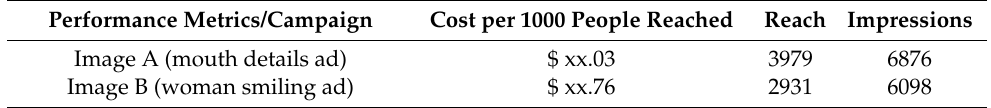
Table 2. A/B split test performance. Performance